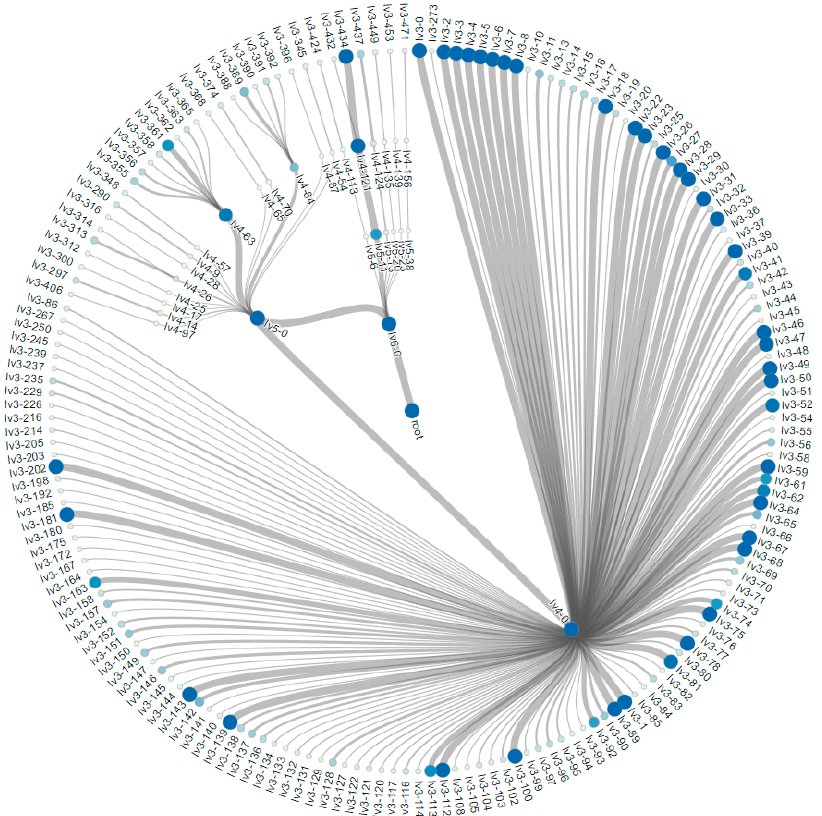
Figure 5. The extended circular dendrogram visualizing the hierarchy built from the MNIST dataset.